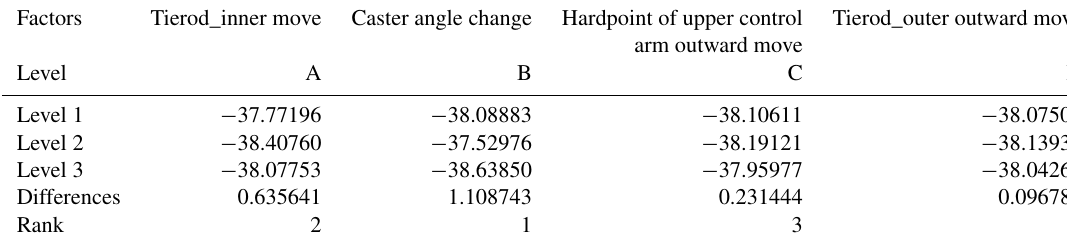
Table 11. SN ratio of the first parameter combination for the Taguchi experiment (steering torque). Factors